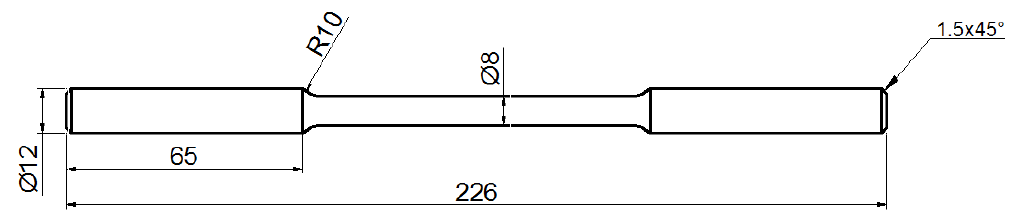
Figure 5. Geometry and dimension of smooth rotating bending fatigue specimen.